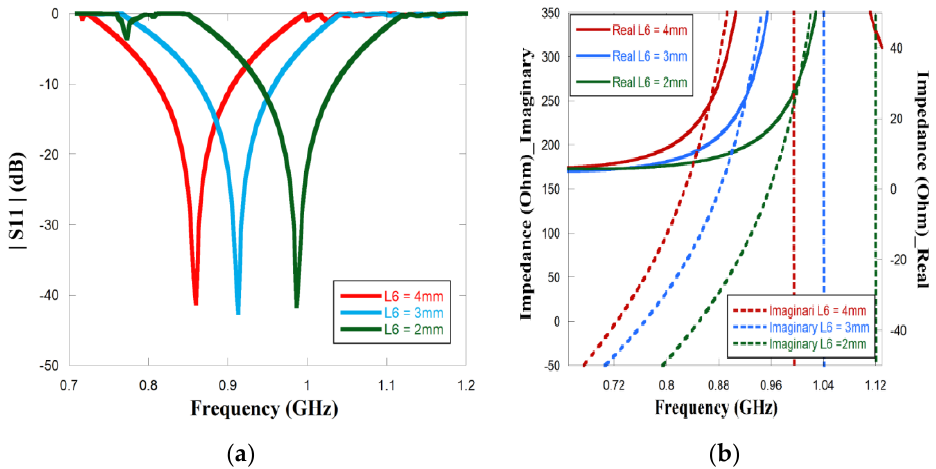
Figure 5. Parametric study of simulated ( a ) | S 11| and ( b ) complex impedance for different L6 .